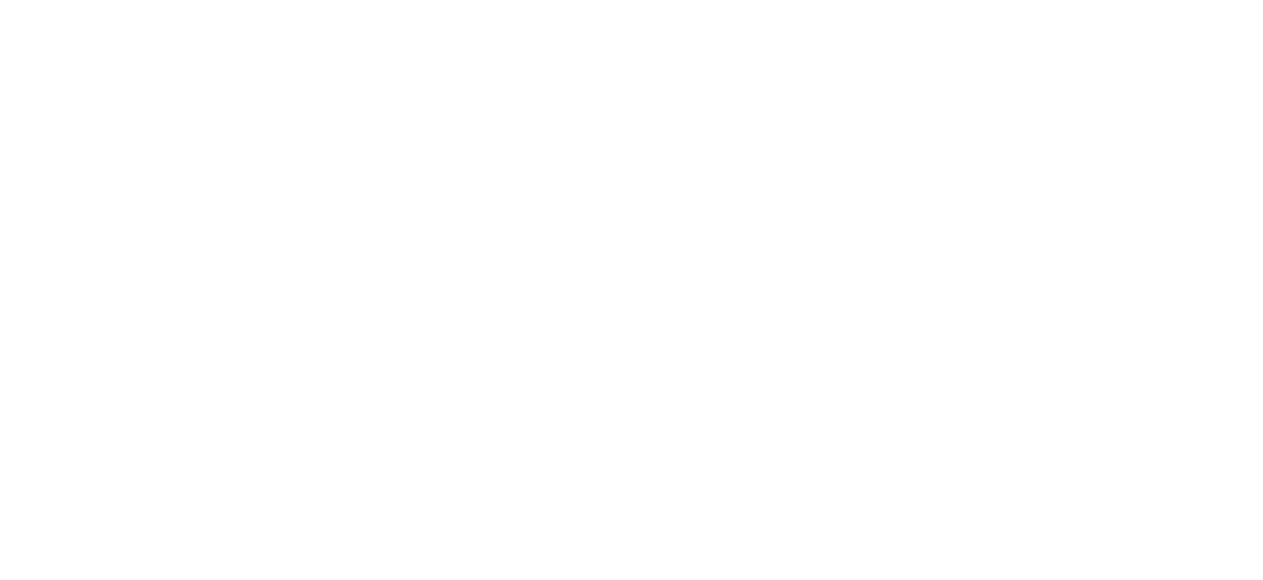
Frontiers in Genome Editing |